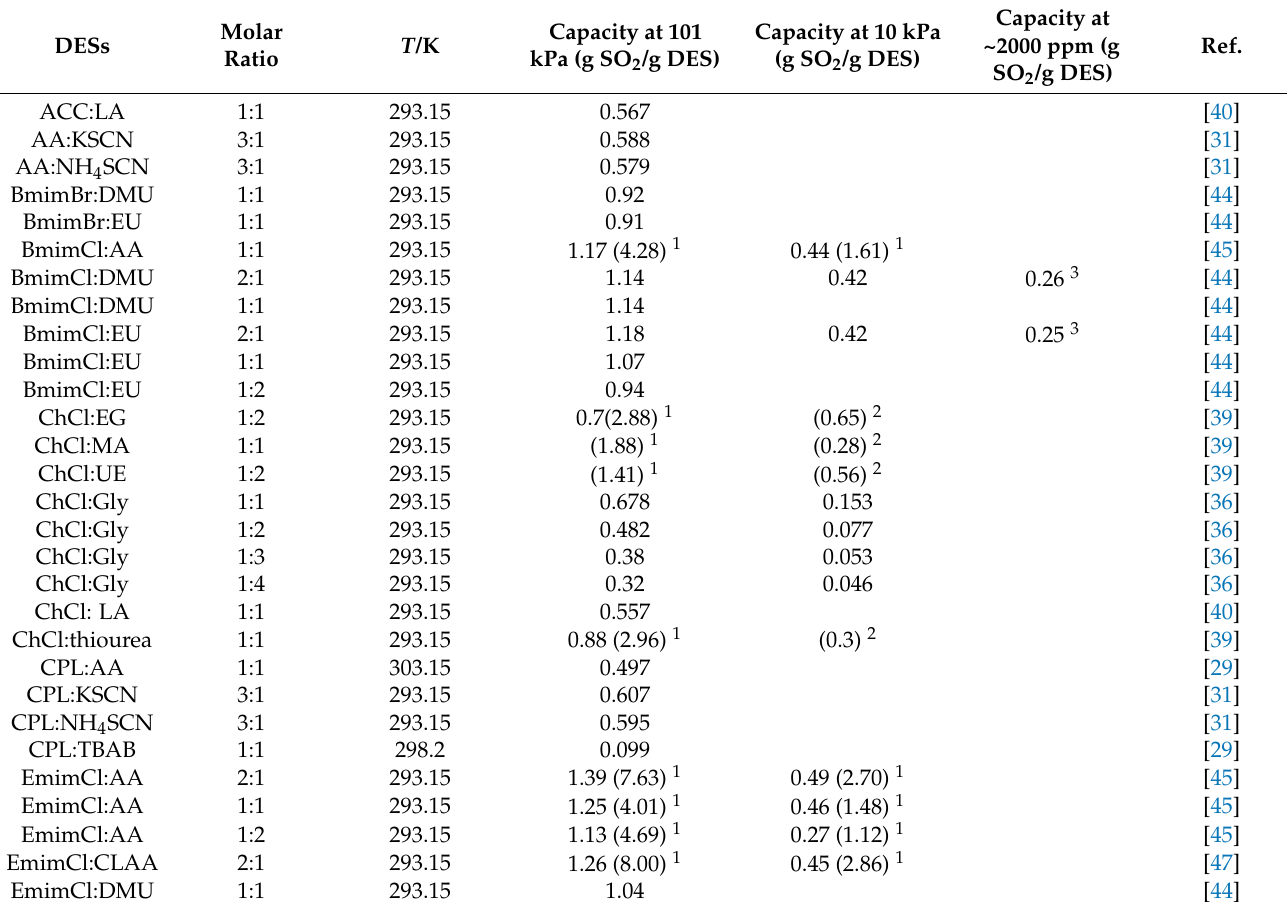
Table 1. SO 2 solubility in non-functionalized